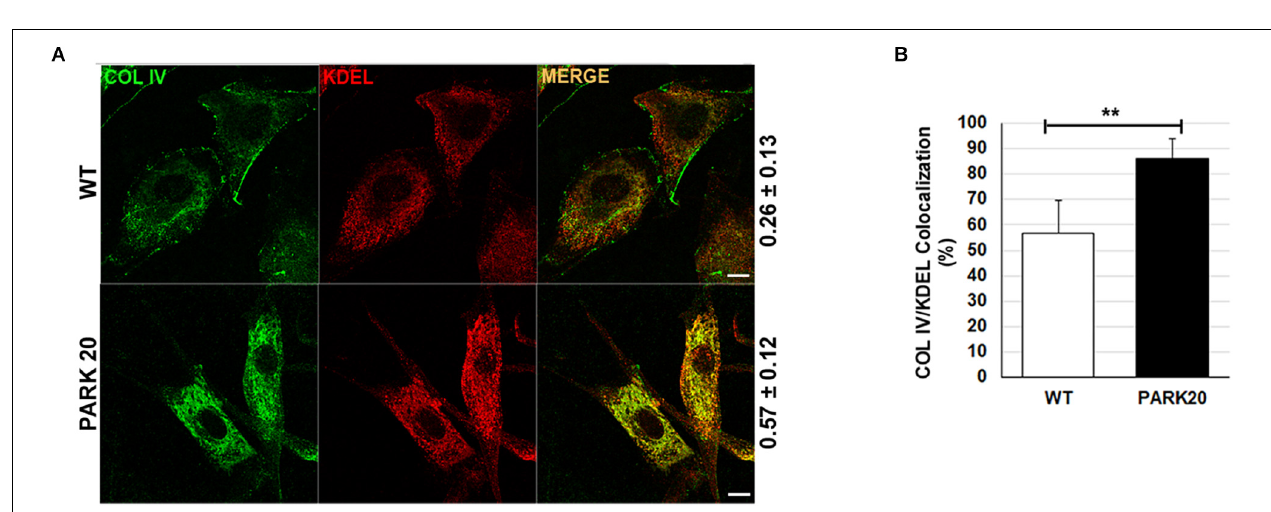
FIGURE 2 | The formation of COPII-coated vesicles are reduced in PARK20 fibroblasts. (A) HDF (WT) and PARK20 cells seeded on glass coverslips were fixed, stained with the indicated antibodies and analyzed by confocal immunofluorescence. Scale bars: 10 µ m. (B) Histogram shows particle count (mean ± SD) of Sec31 (green) and Sec16 (red) fluorescent spots analyzed by Image J. N ≥ 30. ∗ p ≤ 0.05, ∗∗ p ≤ 0.01, Student’s t -test.